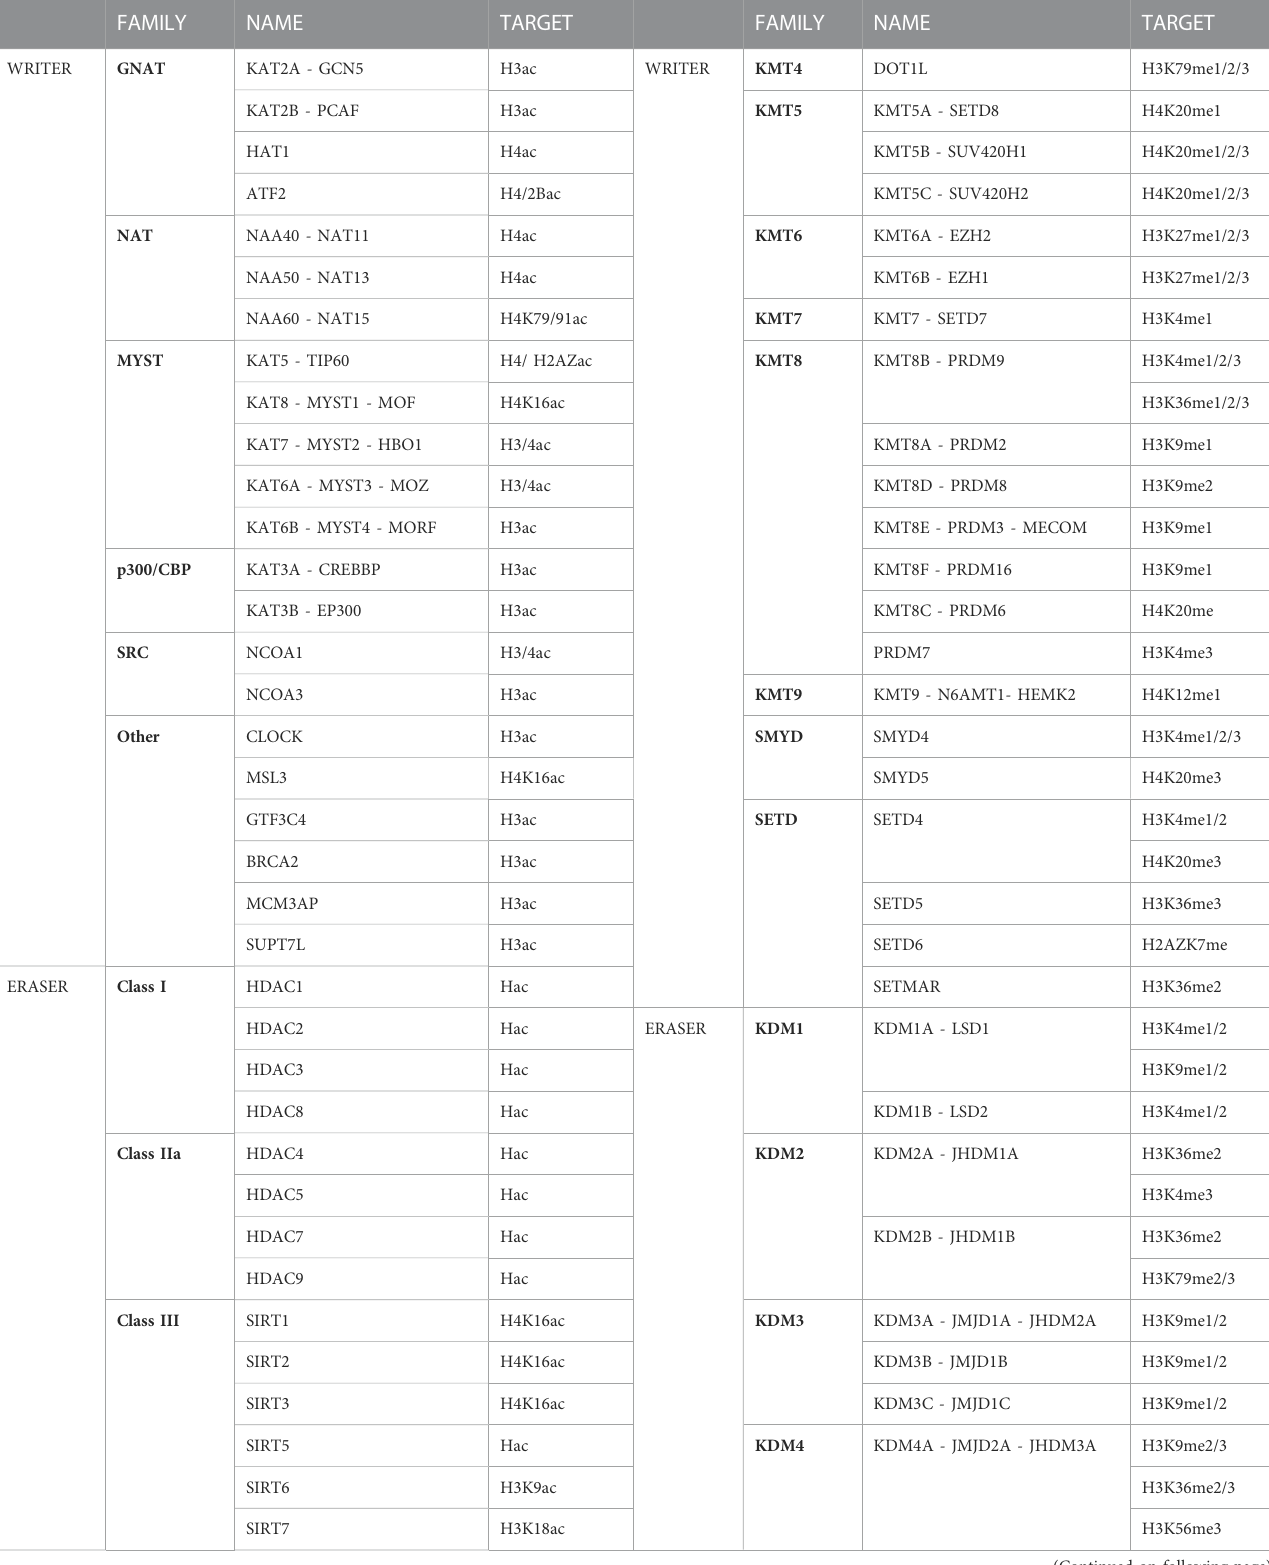
TABLE1WritersanderasersfamiliesforhistoneKacetylationandmethylationandthetargetsdescribed.TheHATscanbedividedintosixmajorfamilies:1)theGNATs (GCN5-relatedN-acetyltransferases),2)theNATs(N-terminalacetylases,whichalsopossessaGNATdomain),3)theMYST,4)thep300/CBP,5)theSRCsteroidreceptors coactivators,and6)otherHATs(WapenaarandDekker,2016).HATsactionsarecounteracted bytheHDACs,whichincludezinc-dependent classI,classIIa,andclassIV HDACs, and NAD-dependent class III Sirtuins (Wapenaar and Dekker, 2016). On the other hand, the KMTs present two domains with annotated lysine methyltransferase activity: 1) SET domains, that catalyze all the canonical methylation sites except for H3K79, and 2) 7 β S domains (DOT1L and N6AMT1) (MosammaparastandShi,2010).TheKDMscanbedividedaccordingtotheircatalyticactivityin:1)amineoxidases(KDM1),and2)JumonjiCdemethylases(KDM2/3/4/ 5/6/7/8) (Mosammaparast and Shi,